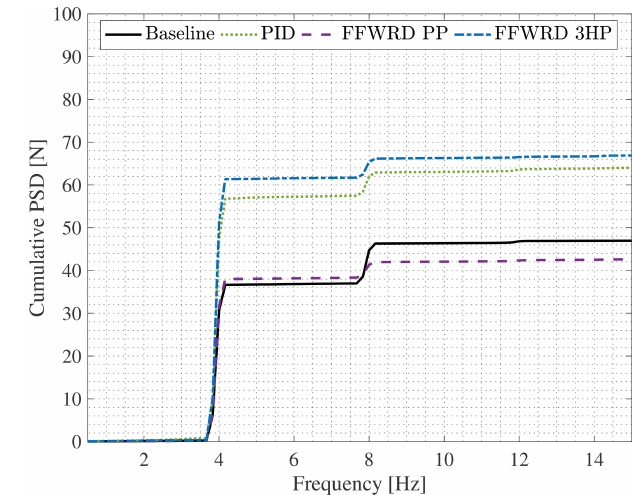
Figure 23. Cumulative power spectral density of the lift amplitude at the reduced frequency of k = 0 .